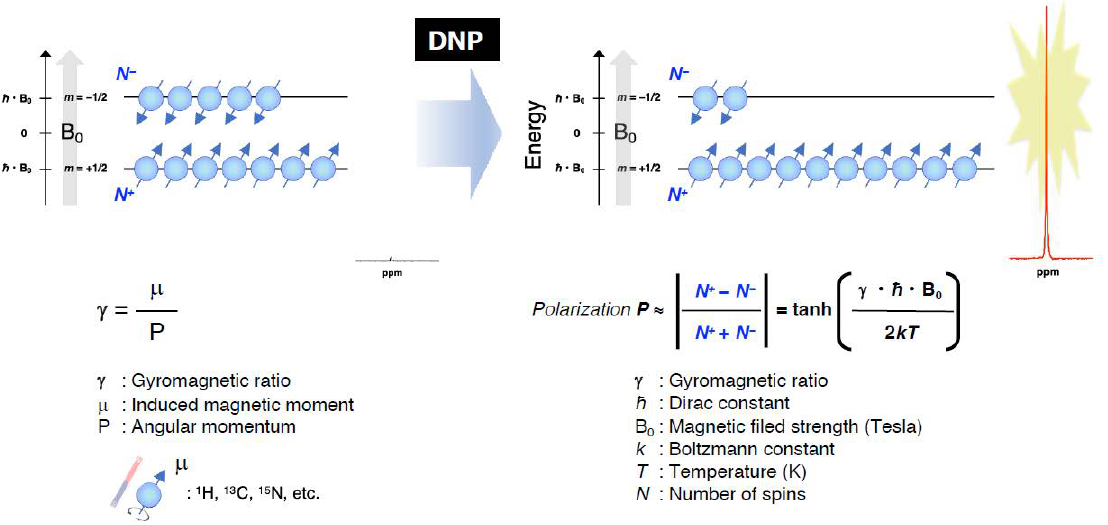
Figure 8. Imaging of mice pO 2 by OMRI/PEDRI. ( A ), Structure of trimethylaryl radical OX063. ( B ), Relative intensity of the different RF power-dependent images. ( C ), Oxygen image in mice body acquired by OMRI/PEDRI. Imaging of oxygenation in the C3H mice-bearing SCCVII tumors after Carbogen challenge. 3.2. Hyperpolarized 13 C MRI The DNP-based double resonance MRI techniques are referred to as hyperpolariza- tion techniques when the nuclear polarization is dramatically increased (several orders of magnitude) as compared to the thermal equilibrium value. Hyperpolarization is achieved by performing dynamic nuclear polarization in solid state (glassy matrix) at very low tem- perature and at high magnetic field, to achieve maximum electron polarization and polar- ization transfer to the magnetic nuclei [113]. Hyperpolarized 13 C MRI is an emerging tech- nique offering enhanced information on metabolism, unparallel to any other current im- aging techniques, with great potential for early detection of disease, staging and treatment monitoring. Further, the metabolic imaging is performed without using ionizing radia- tion. This method requires suitably designed 13 C molecular probe for metabolic imaging. Stable organic radicals of very narrow single line EPR resonance are used as the source of electron spins and excited using high frequency microwave radiation. The main challenge is to bring the polarized, cold solid sample into solution without losing the polarization. The initial experiments demonstrated that high polarization, 37% for 13 C and 7.8% for 15 N, can be obtained in solution with corresponding signal enhancements of 44,400- and